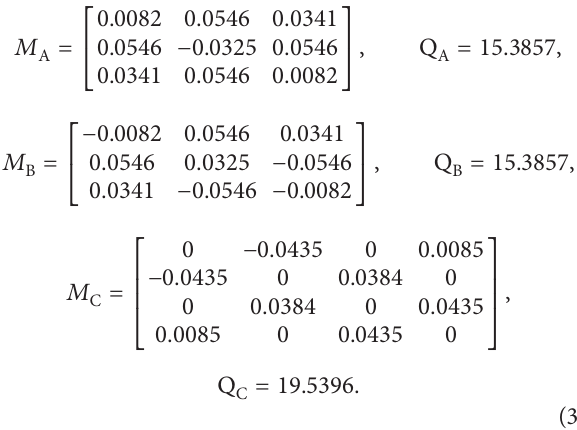
geometrical parameters and eigenfrequencies of a